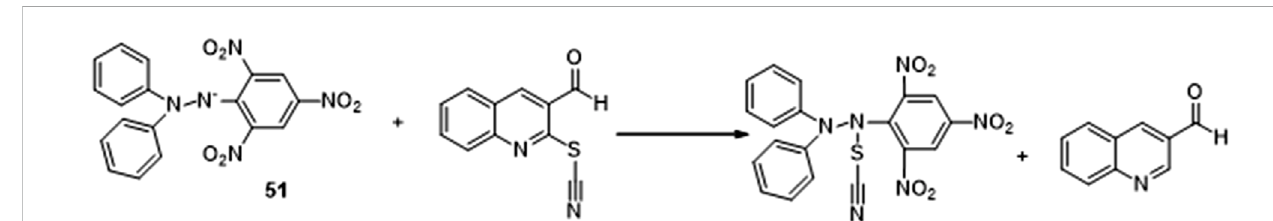
SCHEME 11 Mechanism of compound 51 scavenging activity.